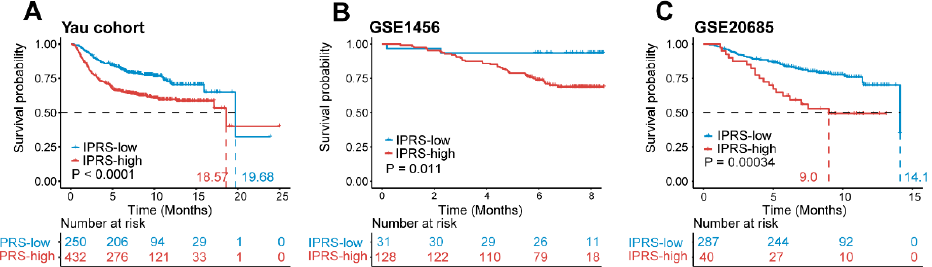
Figure 6. Comparisons of OS between the IPRS-high and IPRS-low groups across different cohorts. ( A – C ) Kaplan–Meier survival curves of OS comparing the IPRS-high and IPRS-low groups among patients with breast cancer from the Yau cohort ( A ), the GSE1456 ( B ), and the GSE20685 ( C ).